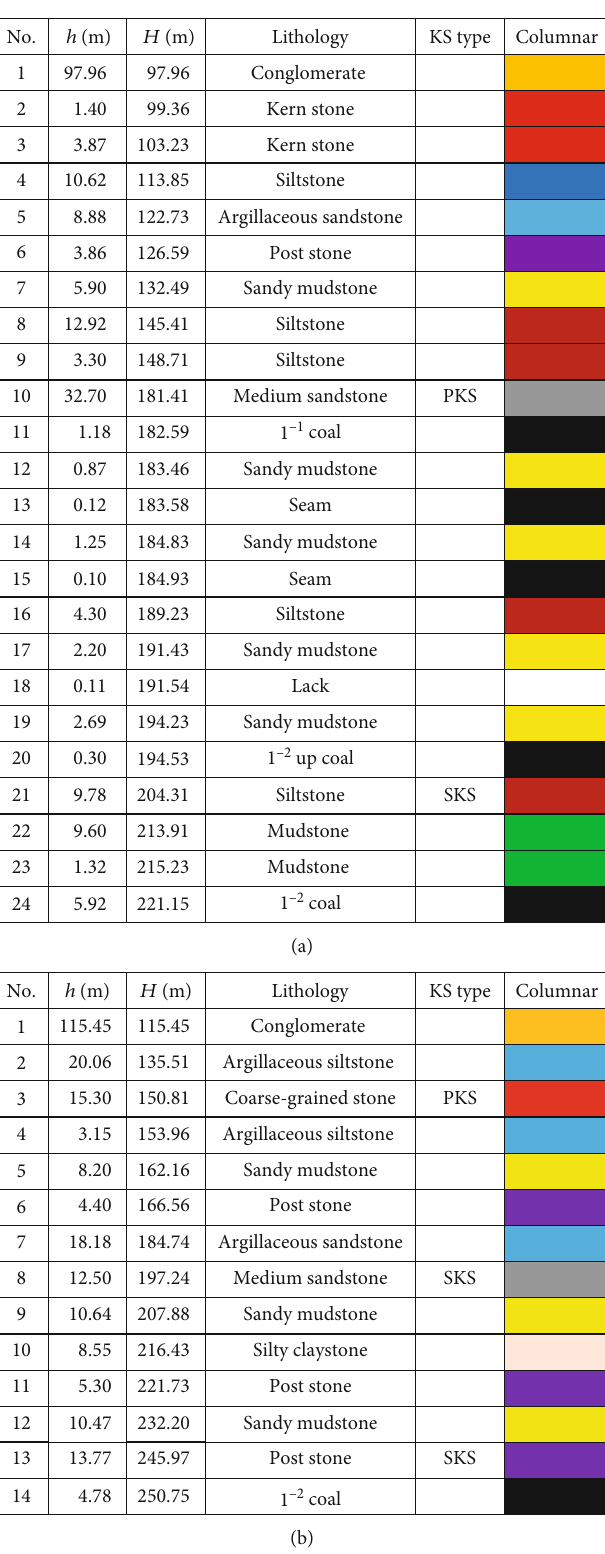
Figure 9: Histogram in water inrush and normal areas of 31401 working face of Bulianta Coal Mine [25]: (a) overburden histogram in water inrush area; (b) overburden histogram in normal